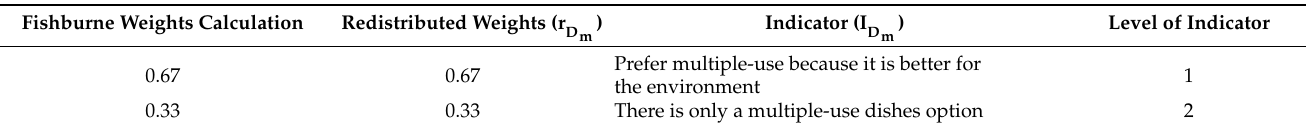
Table 18. Reasoning indicators for multiple-use